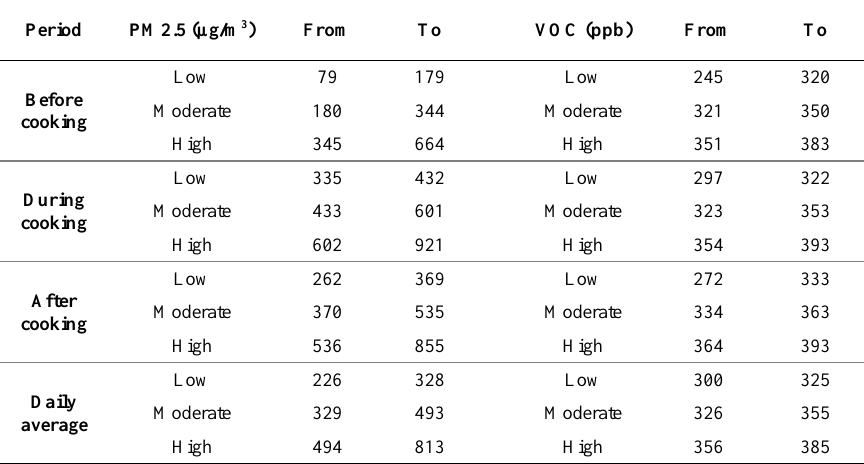
Table 4. PM2.5 and VOC concentration index